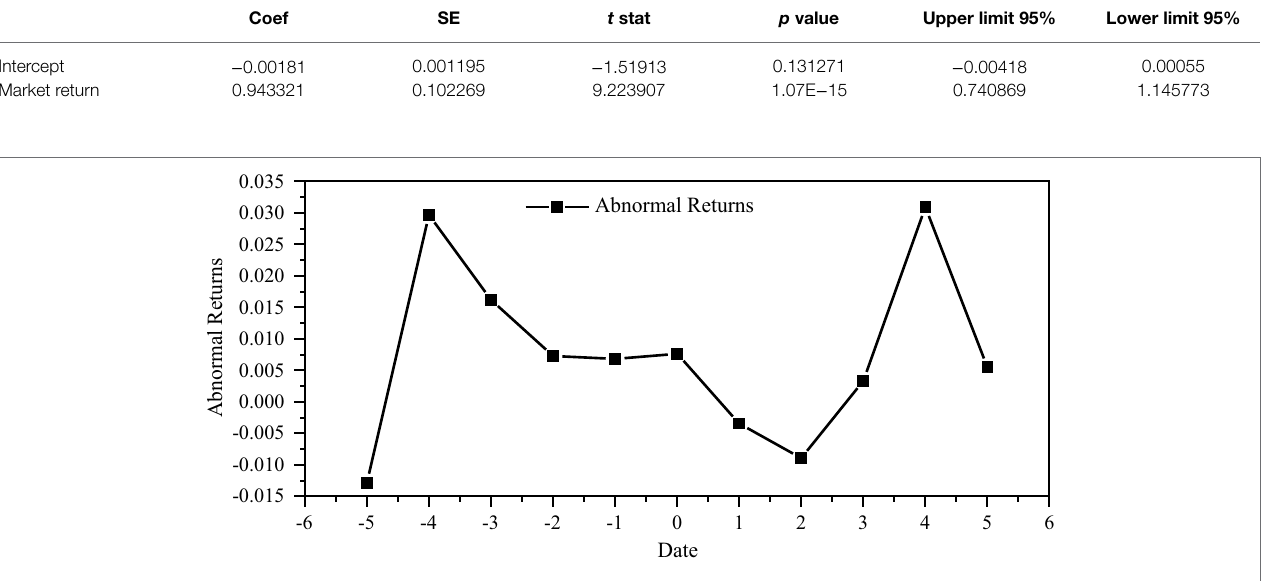
FIGURE 3 | Abnormal returns during the event window.